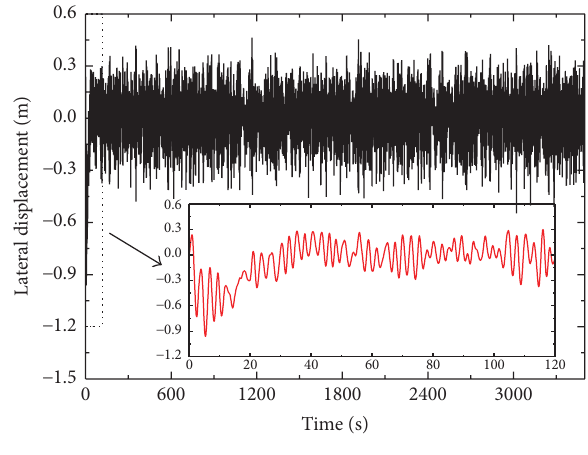
Figure 3: Time history of lateral displacement.